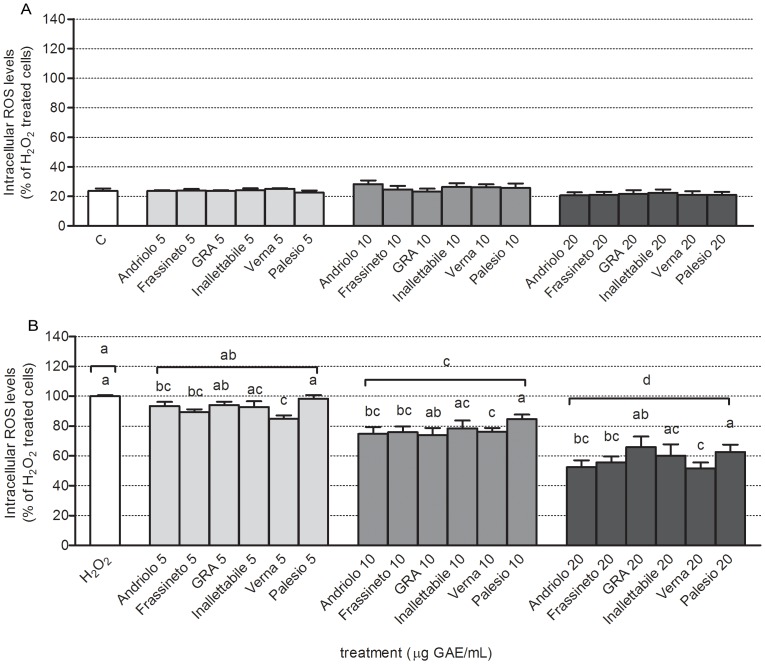
Evaluation of intracellular ROS production in primary cultures of neonatal rat cardiomyocytes.Cells were pre-treated with different concentrations of phenolic extracts of different wheat varieties (5, 10, 20 µg GAE/mL) for 24 h and intracellular ROS levels were measured in the absence/presence of 100 µM H2O2 as reported in Materials and Methods. Panel A represents basal intracellular ROS levels in cells pre-treated with different concentrations of phenolic extracts for 24 h, while panel B reports intracellular ROS levels measured in cells pre-treated with different concentrations of phenolic exctracts for 24 h and stressed by treatment with 100 µM H2O2 for 30 min. Data are reported as percent of H2O2-treated cells and represent mean +/− SEM of 4 independent experiments, each in triplicate. Statistical analysis of differences was carried out by two way ANOVA followed by Fisher's LSD as post test. Different letters represent statistically significant differences (p<0.05) among wheat varieties at the same concentration (lower letters) and among different concentrations (upper letters).